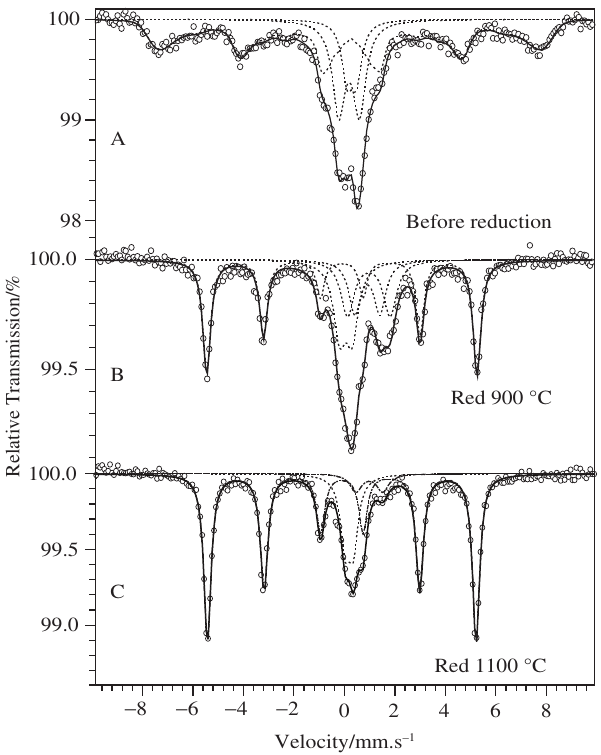
Figure 9. Mössbauer spectra at 298K of the perovskite